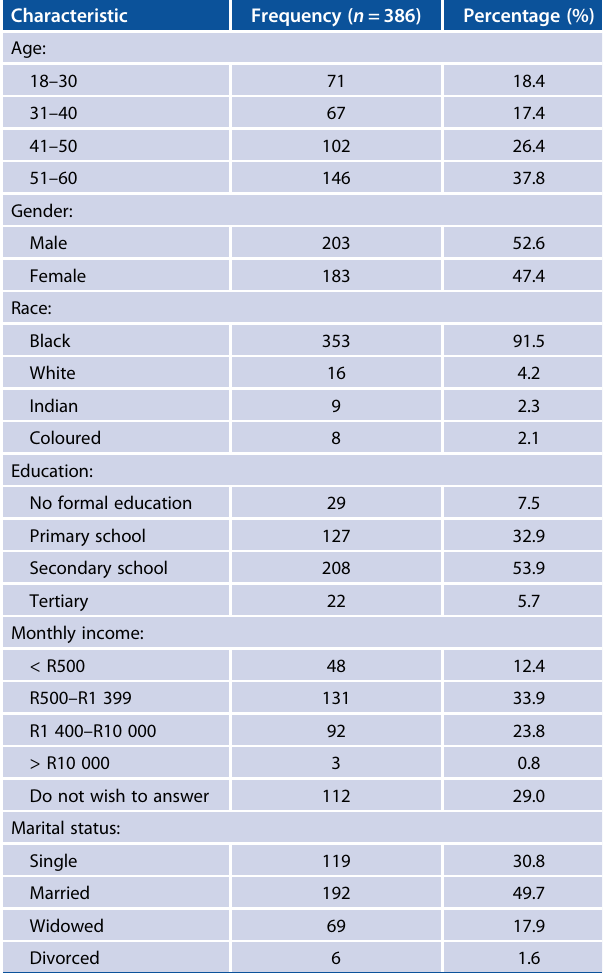
Table 1: Sociodemographic characteristics of patients at the Medical Outpatient Department at Prince Mshiyeni Memorial Hospital, 2017